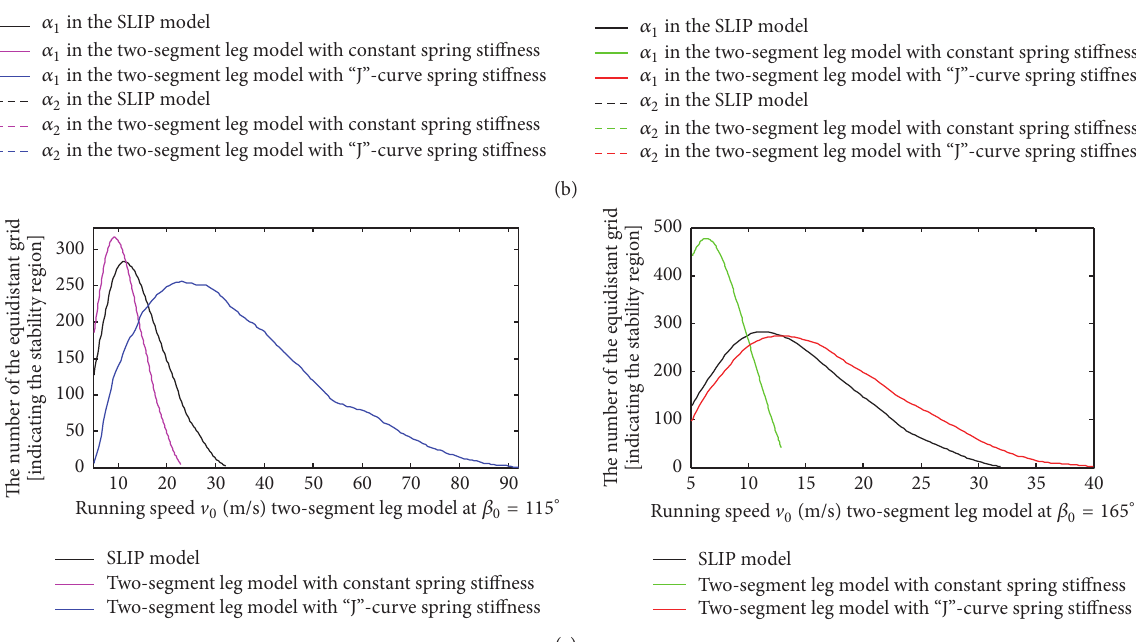
̃ 𝑘 𝛼 10 % and 0 at different running speeds in the SLIP model, the 𝛼 1 denotes the difference between the minimum and maximum landing angles, and